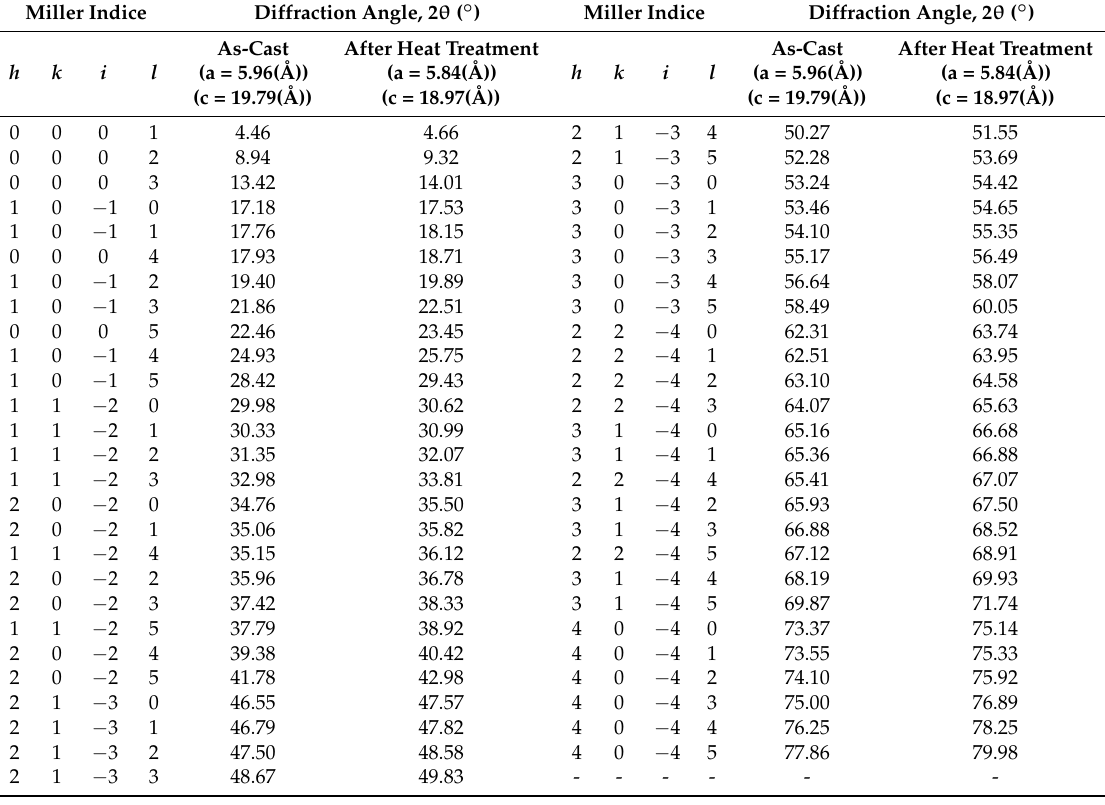
Table 5. Miller indices and calculated diffraction angles of (Mg,Al) 2 Ca Laves phase. Miller